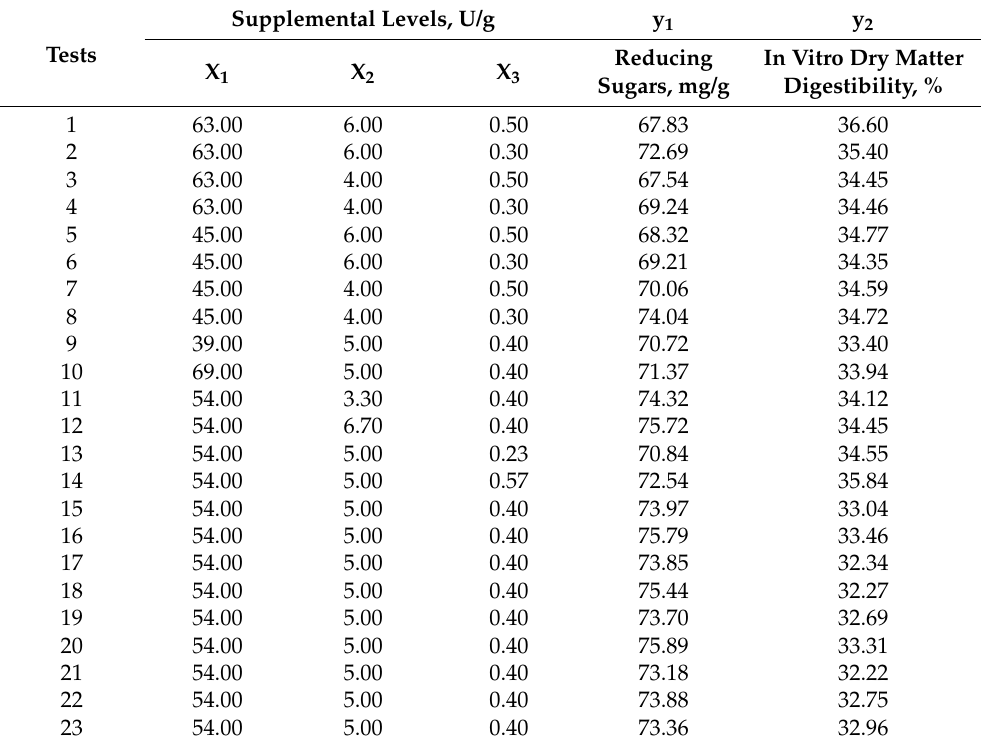
Table 4. Box–Behnken design of exogenous carbohydrases with coded values and predicted response index values